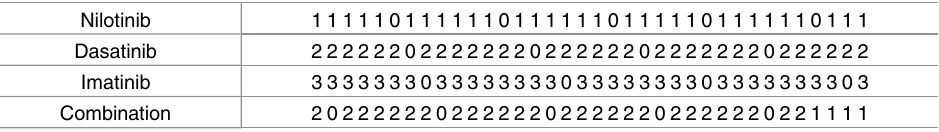
Table 7. Treatment schedules with drug